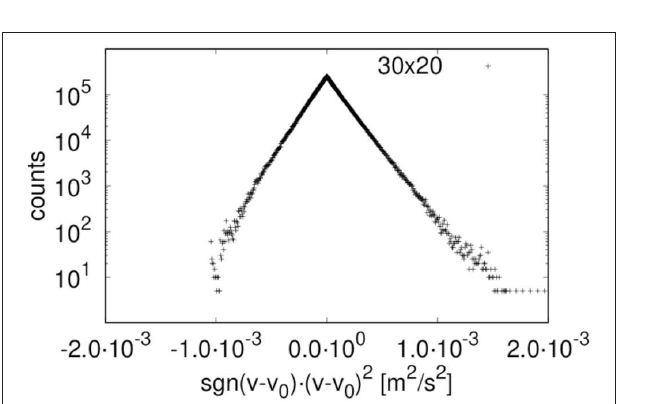
FIGURE 3 | Distribution of network-averaged instantaneous total (wetting and non-wetting) fluid velocity for network size 30 x 20 (case A). v 0 is the total average velocity and sgn is the sign function.